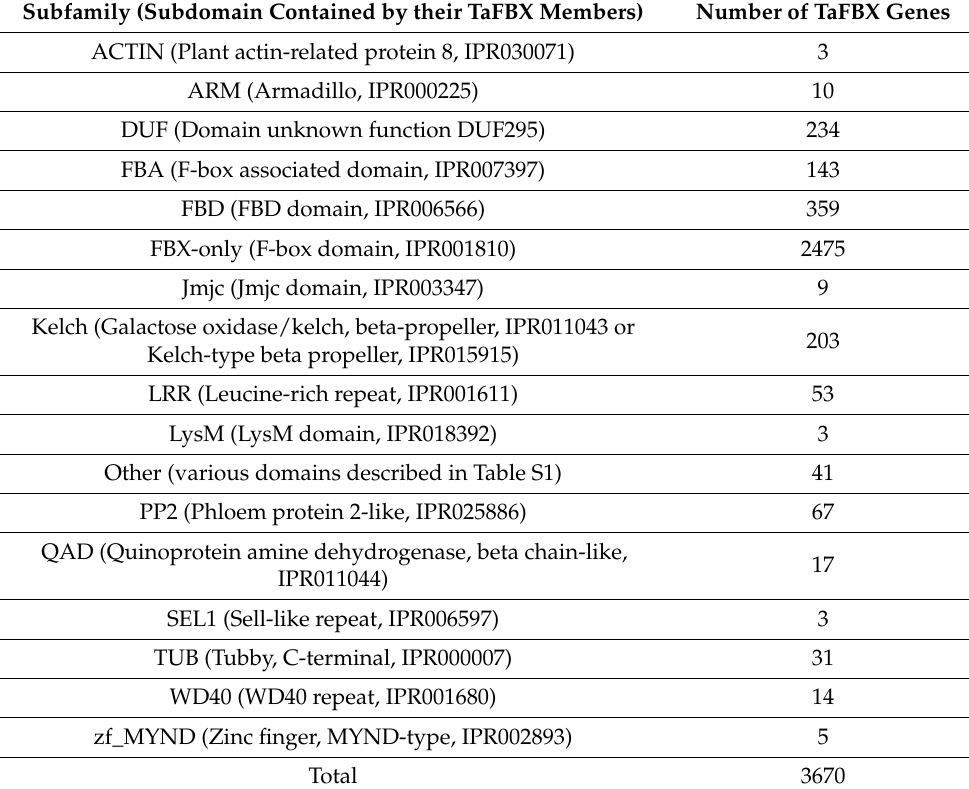
Table 1. Distribution of the TaFBX genes among 17 subfamilies, in view of the presence of the F-box domain and other FBX-specific domains. The FBX-only subfamily carries only the F-box domain. The “Other” subfamily contains TaFBX genes with rarely observed